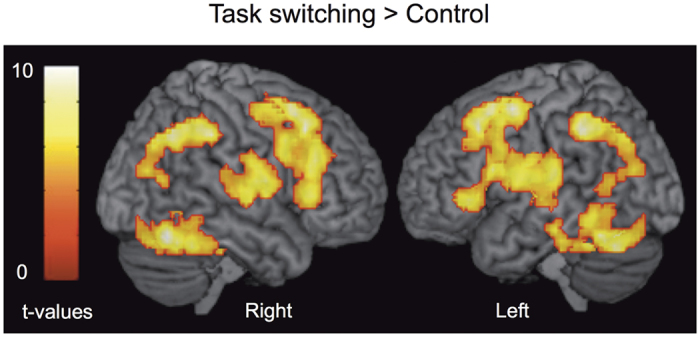
Brain regions engaged by task switching compare to control, regardless of treatment type.Data for brain regions commonly activated by task switching relative to control, regardless of hormonal status, were overlaid onto a 3D-rendered brain (Display threshold: voxel-wise p < 0.001, uncorrected; cluster-wise p < 0.05, FWE corrected).